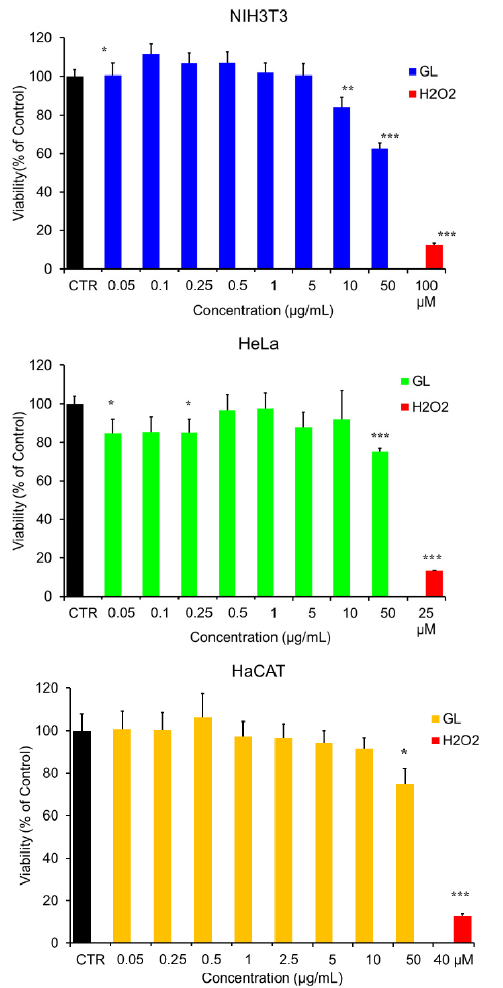
Figure 5. Cytotoxicity (percent of untreated control) of NH3T3 (( upper ) panel), HaCAT (( central ) panel) and HeLa (( lower ) panel) cell lines determined by the MTT assay ( ± S.D.), following exposure to GL suspension at the indicate concentrations. Asterisks denote significant differences at p < 0.05 (*), p > 0.01 < 0.05 (**) and p < 0.01 (***).